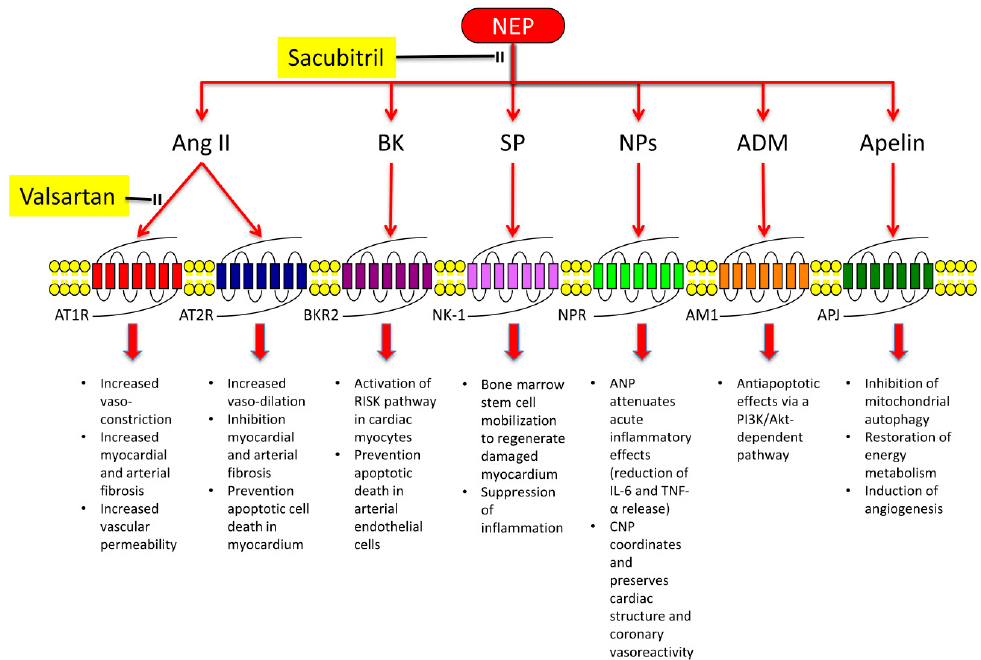
Figure 1. Effects of angiotensin receptor and neprilysin (NEP) inhibition. Angiotensin receptors type 1 (AT1Rs) inhibition by valsartan reduces vasoconstriction, myocardial fibrosis, and vascular permeability induced by angiotensin II (Ang II). Consistently, it favours vasodilation and cell protection against apoptotic death through angiotensin receptors type 2 (AT2Rs). NEP inhibition by sacubitril increases levels of natriuretic peptides (NPs), bradykinin (BK), substance P (SP), adrenomedullin (ADM), and apelin, thereby amplifying protective pathways mediated by these molecules. BKR2: bradykinin receptor 2; NK-1: neurokinin-1 receptor; NPR: natriuretic peptide receptor; AM-1; adrenomedullin receptor-1; APJ: apelin receptor; RISK: reperfusion injury salvage kinase; IL-6: interleukin 6; TNF- α : tumor necrosis factor- α